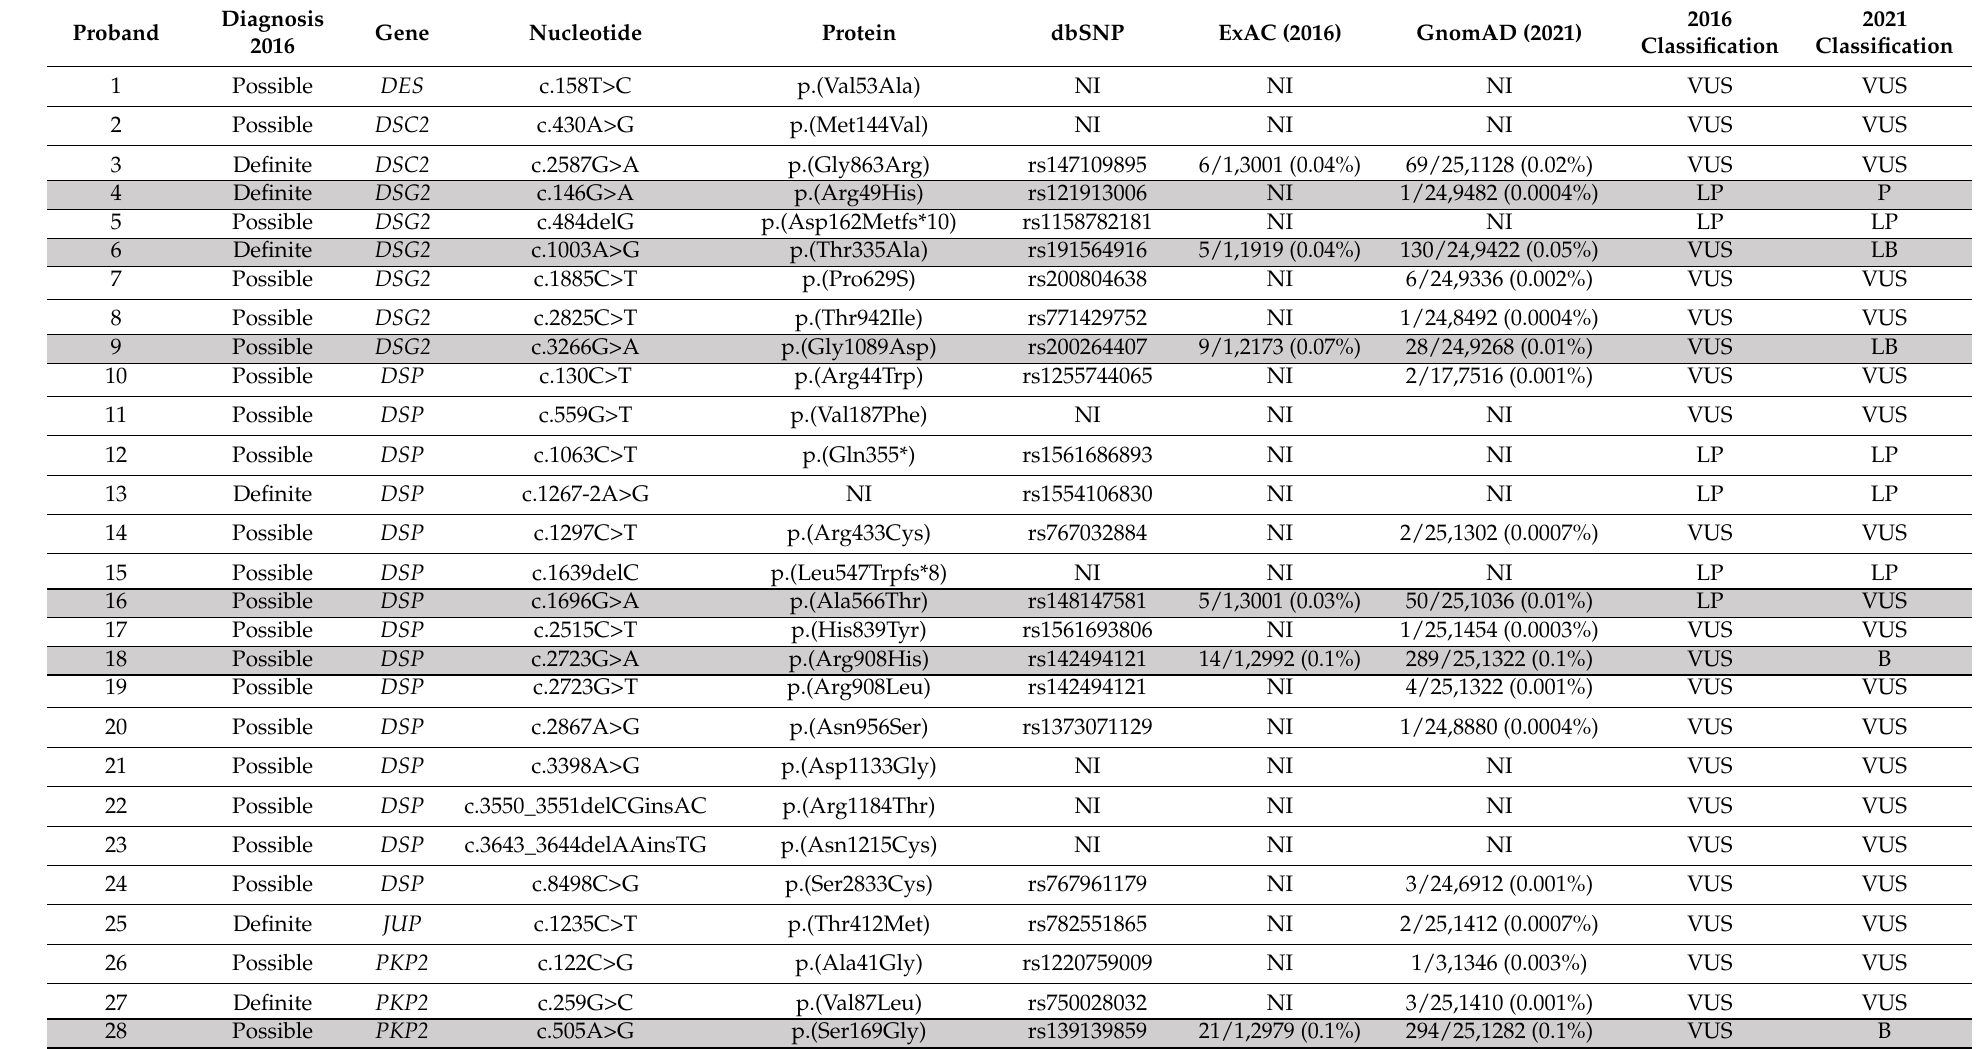
Table 1. Rare variants found in ACM patients (grey indicates variants that have been